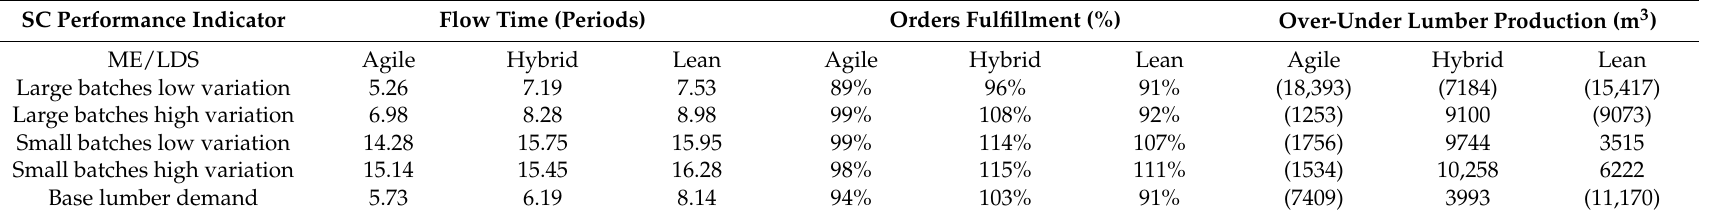
Table A9. Supply chain performance metrics by lumber demand scenario (LDS) and manufacturing environment